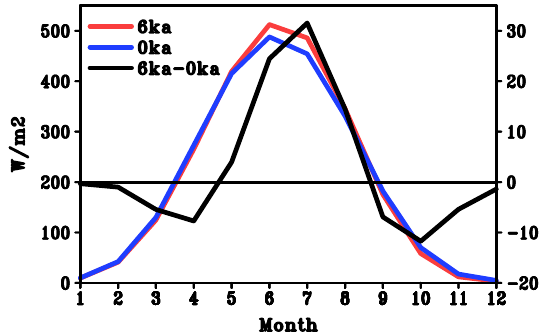
Fig. 2. Incoming solar radiation (W/m 2 ) at the top of the atmo- sphere averaged over 60 ◦ N–90 ◦ N for the mid-Holocene (6ka, red), pre-industrial (0ka, blue) and the difference between the two (6ka– 0ka, black). The left-hand vertical axis refers to the absolute values and the right-hand scale to the difference values.